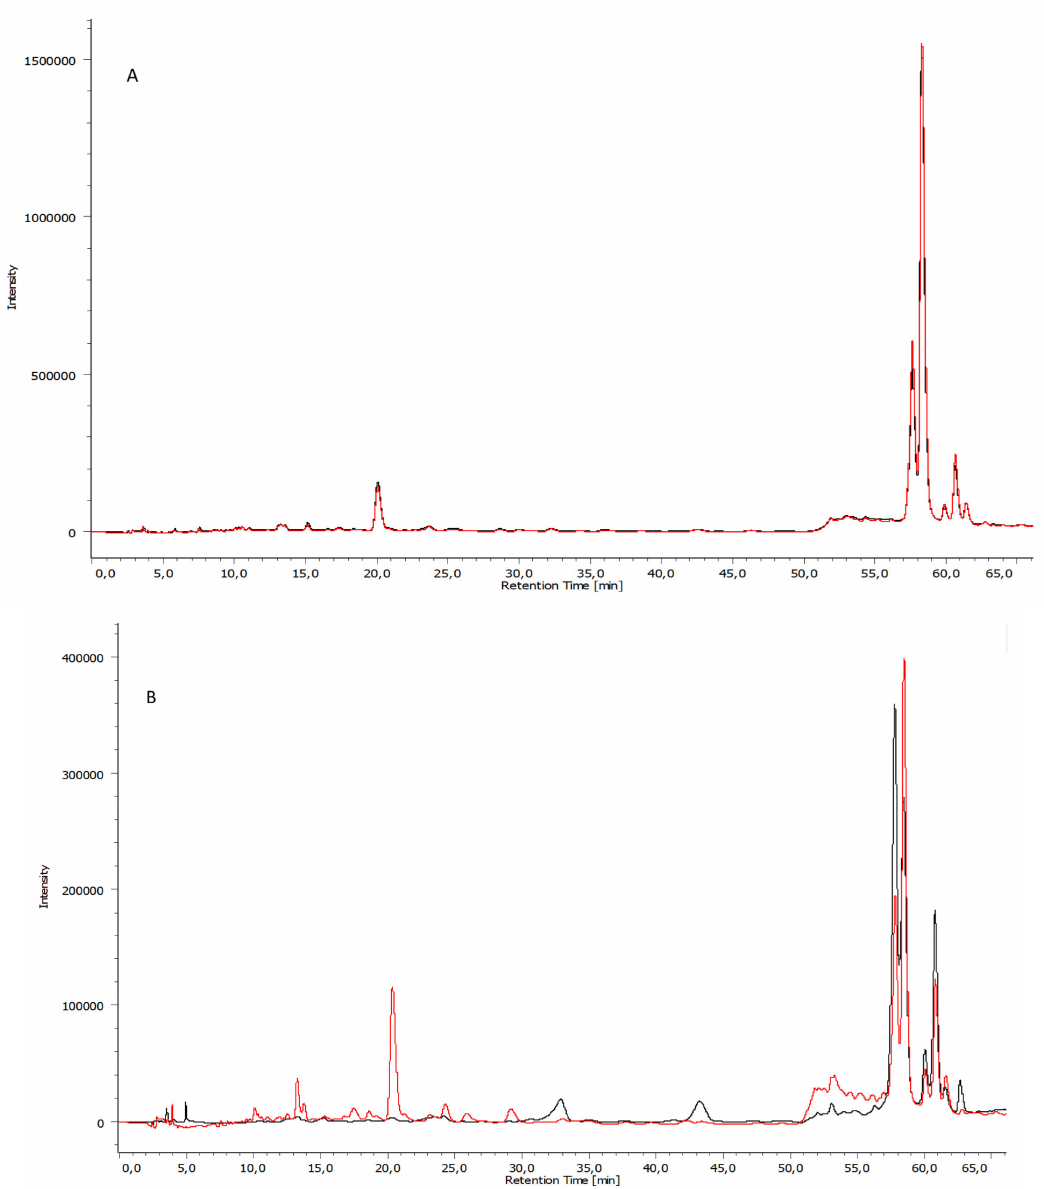
Figure 4. HPLC profile of Aglianico of November leaf extract at 280 nm. ( A ) MeOH:H 2 O (70:30) (red line) and H 2 O (black line). ( B ) MetOH:H 2 O (70:30) (red line) and EtOH (black